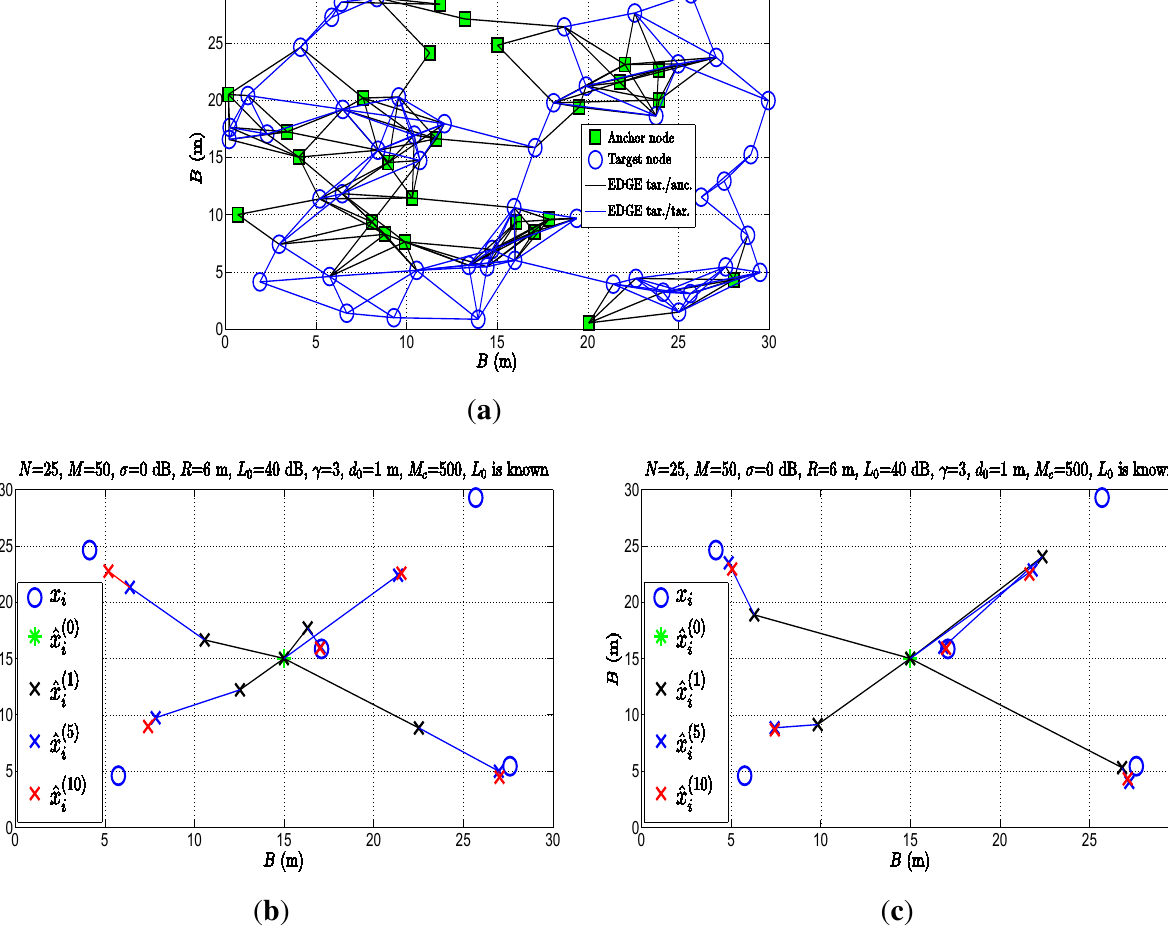
Figure 8. Estimation process of the proposed approach in the first 10 iterations. ( a ) Network configuration; ( b ) SOCP1 approach, w = 0 ; ( c ) SOCP1 approach, w = 1